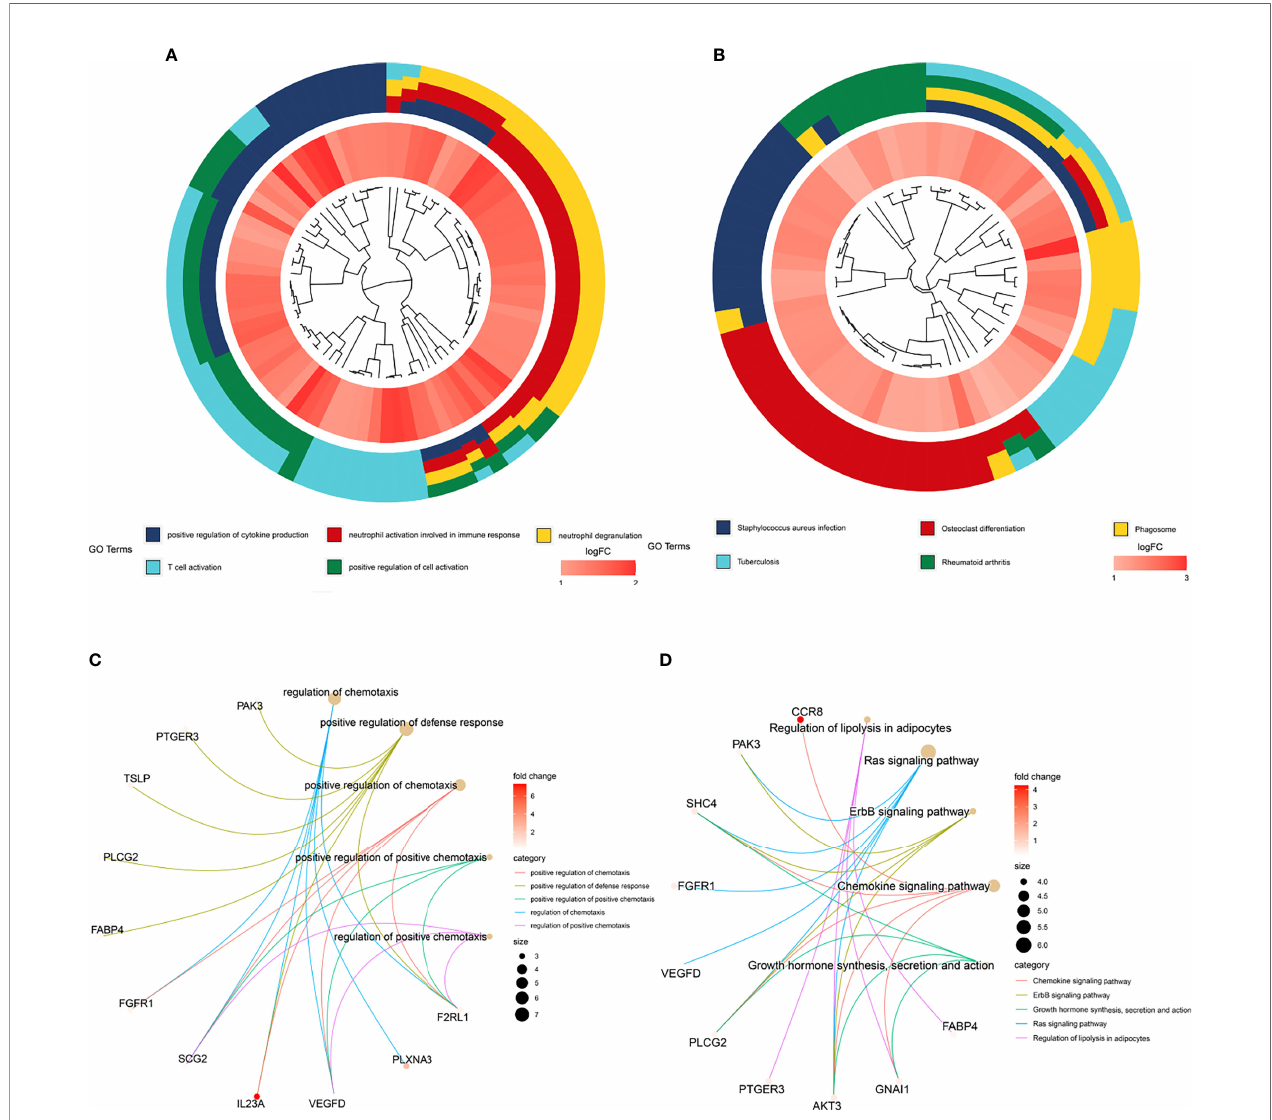
FIGURE 4 | GO and KEGG enrichment of genes. (A) Top fi ve GO enrichment terms of the turquoise module genes. (B) Top fi ve KEGG enrichment pathways of the turquoise module genes. (C) Top fi ve GO enrichment terms of the prognostic genes identi fi ed through multivariate Cox regression analysis. (D) Top fi ve KEGG enrichment pathways of the prognostic genes identi fi ed through multivariate Cox regression